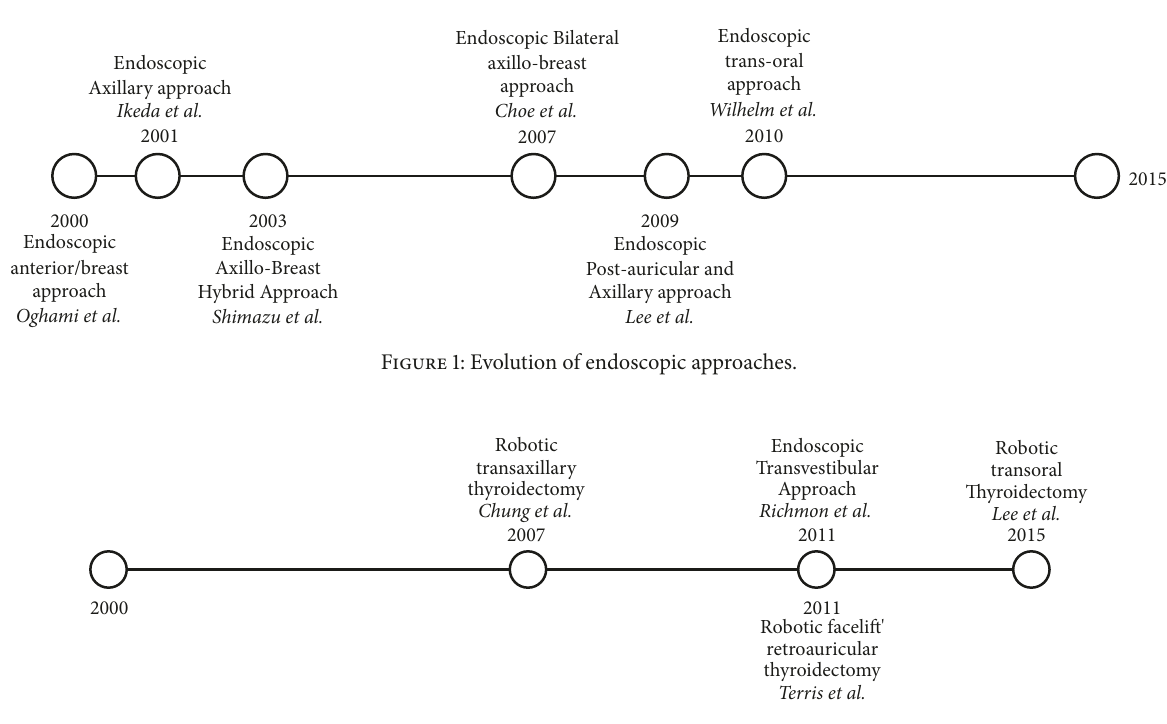
Figure 2: Evolution of robotic